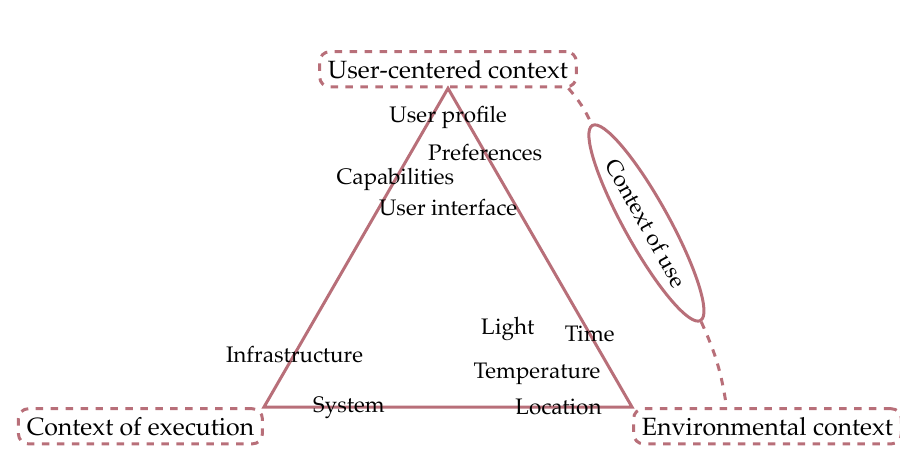
Figure 1: A classi fi cation of context